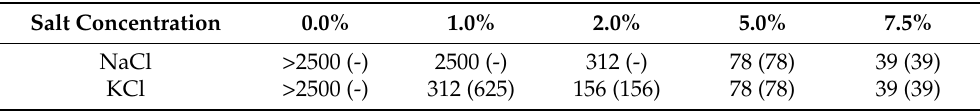
Table 1. MIC and MBC (between brackets) values for RL (µg/mL) against L. monocytogenes Scott A at different NaCl and KCl concentrations.